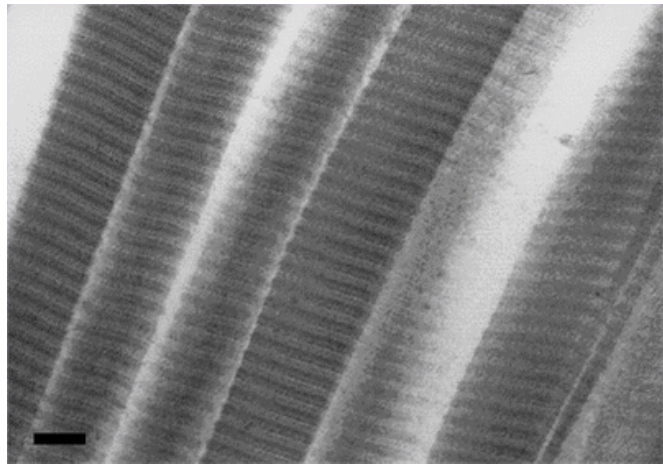
FIGURE 8. Electron micrograph of longitudinally sectioned flexor digitorum tendon of rat. Collagen fibers result from the aggregation of parallel straight collagen fibrils with a D-period and and a bimodal-plurimodal diameter. Inside each collagen fibril the almost straight arrangement of microfibrils is detectable. Bar = 0,3 μ